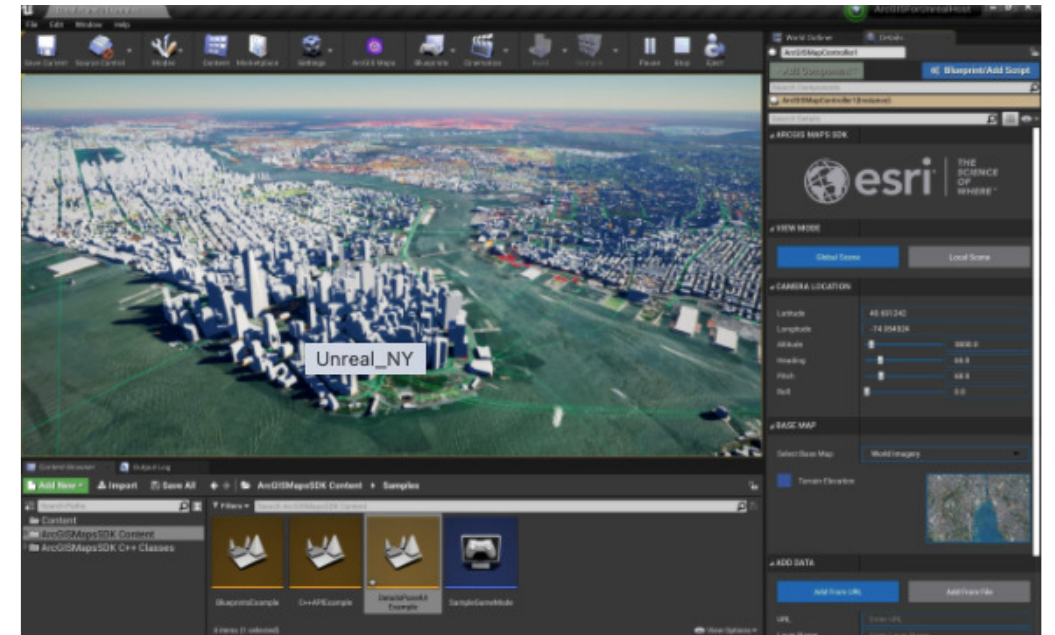
Figure 6. New York GIS data in the Unreal game engine via